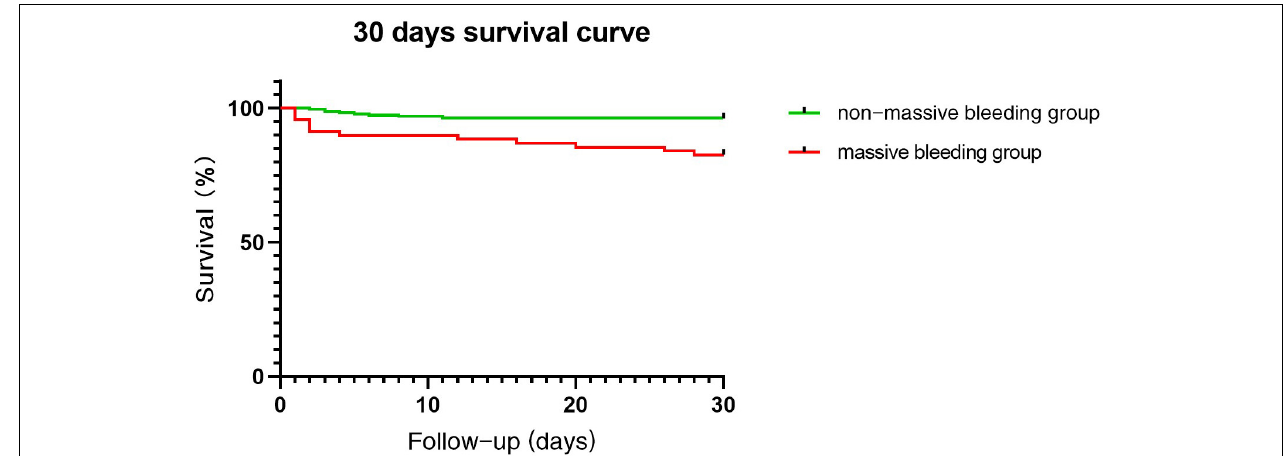
FIGURE 2 | Survival in patients with and without massive